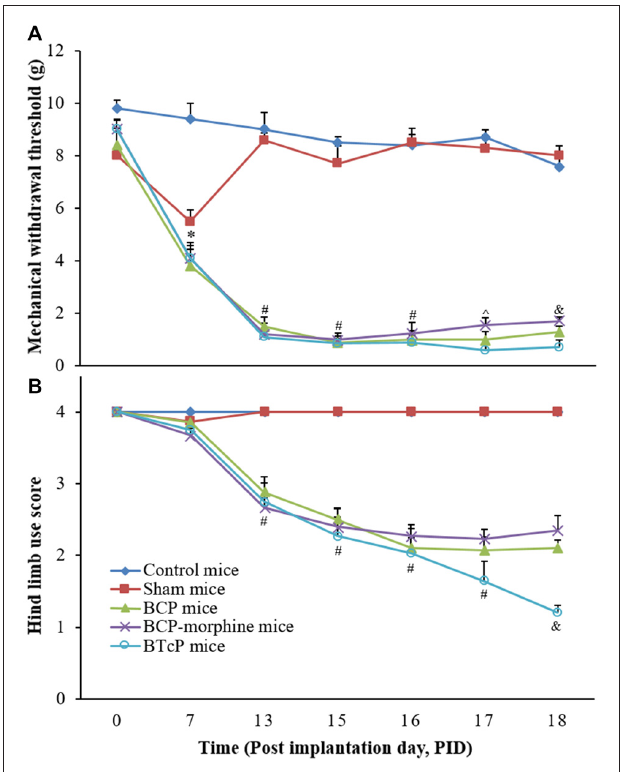
FIGURE 1 | Evaluation of the paw withdrawal mechanical threshold (PWMT) of left hind paw (A) and hind limb use score (B) in normal, sham, bone cancer pain (BCP), BCP-morphine and Breakthrough cancer pain (BTcP) mice. The tests of PWMT of left hind paw and hind limb use score in mice were performed at 8 am. Five mice were used for each group. ∗ P < 0.05, sham, BCP, BCP-morphine or BTcP mice vs. control mice; # P < 0.05, BCP, BCP-morphine, or BTcP mice vs. sham mice; ∧ P < 0.05, BTcP mice vs. BCP-morphine mice; & P < 0.05, BTcP mice vs. BCP or BCP-morphine mice.